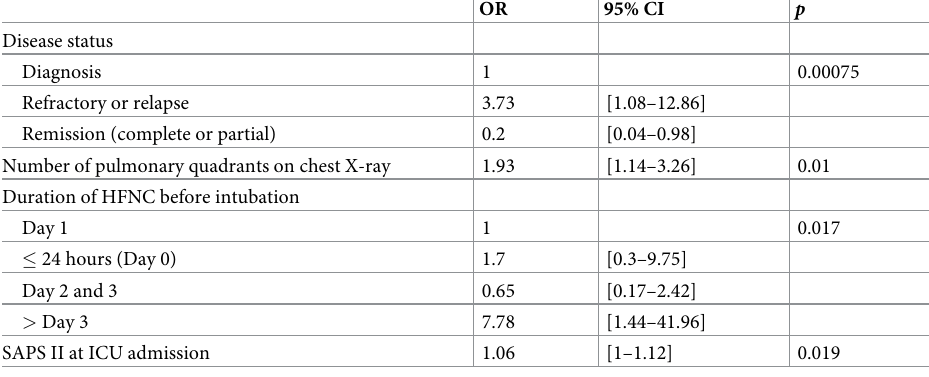
Table 2. Multivariate analysis of prognostic factors associated with hospital mortality in patients with HFNC failure.